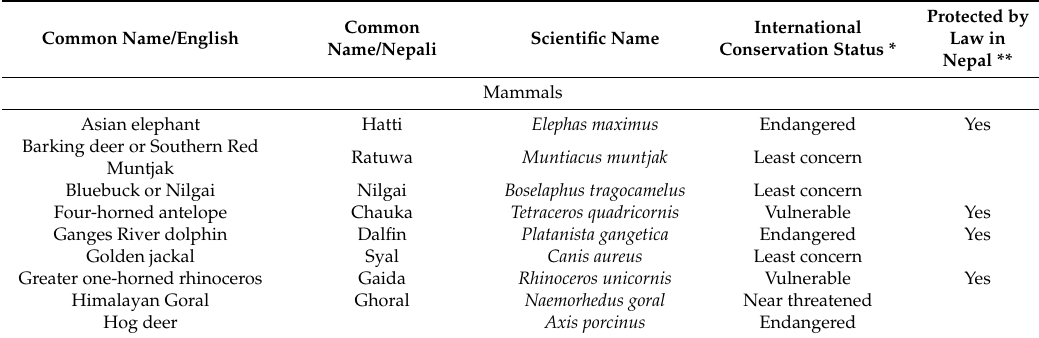
Table A1. List of plants and animals named in the